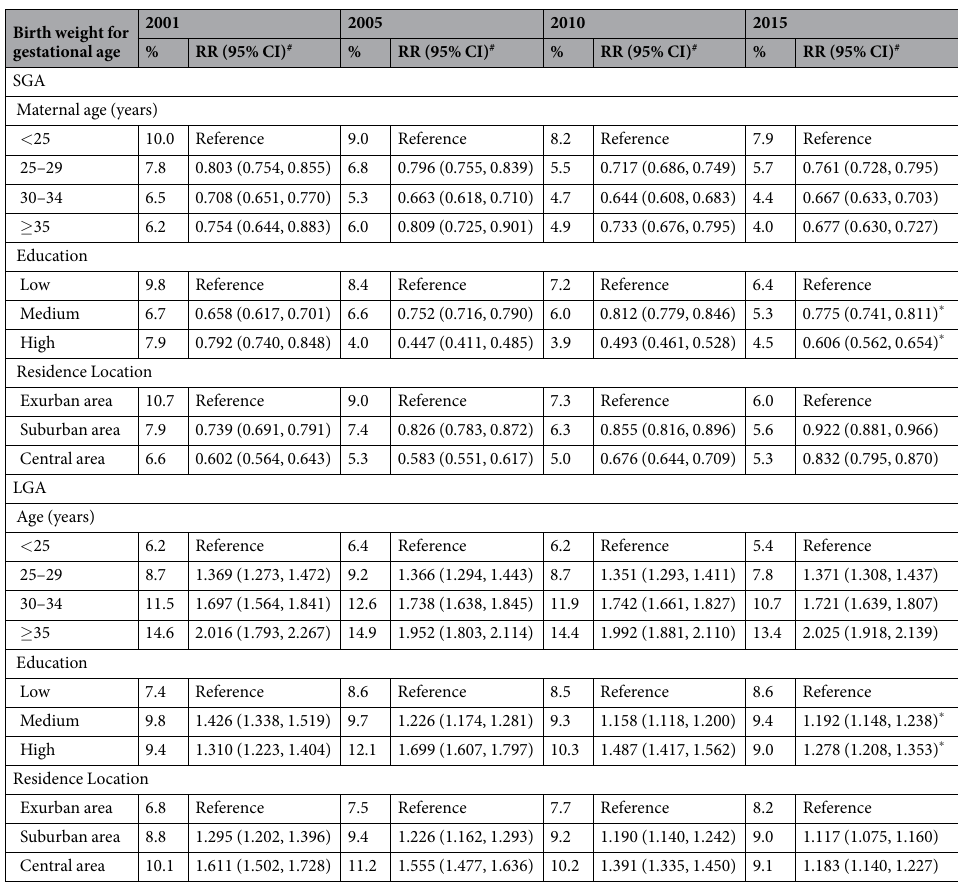
Table 4. Risk of SGA and LGA by maternal characteristics in selected years. * Results for educational level were obtained using data in 2013. # Adjusted for variables as in model 2 plus gestational